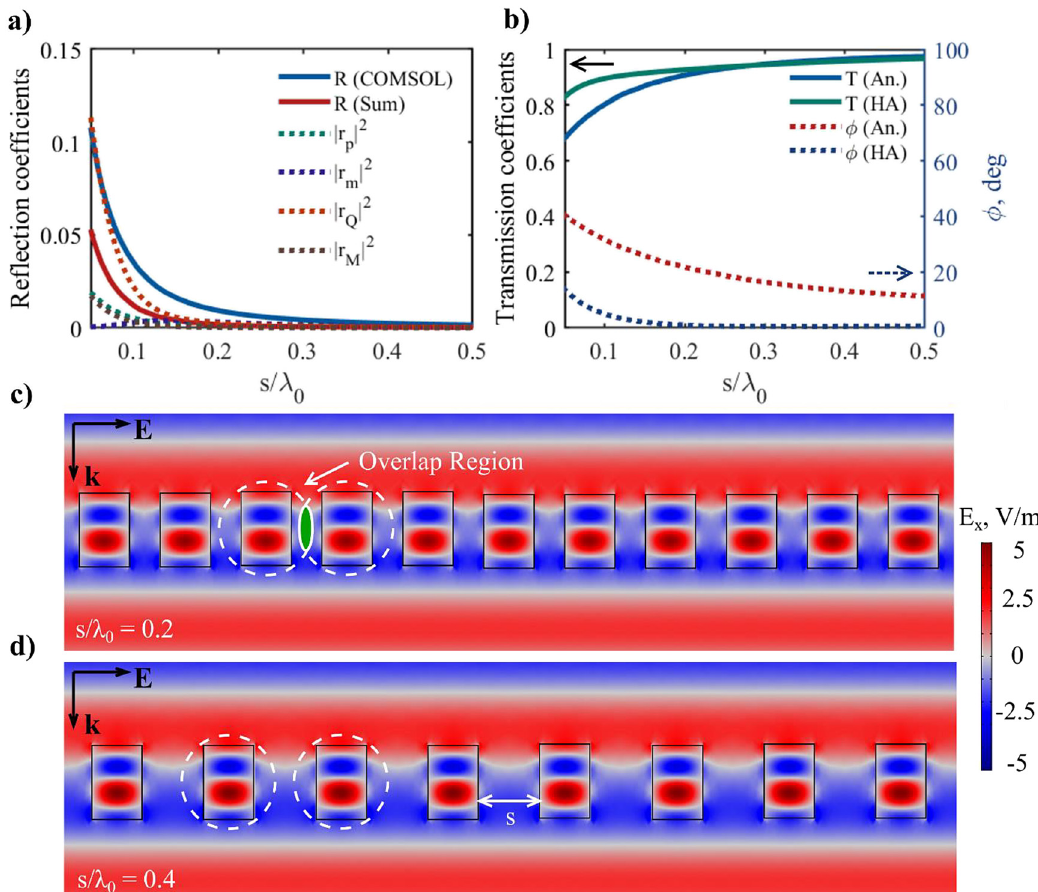
Figure2: OpticalresponseoftheHAmetasurfacewithparticleseparation s (thegeometricalparametersarethesameasinFigure1).Evolution of re fl ection (a), and transmission (b) at λ 0 . (c) and (d) x -component of the total electric fi eld for s / λ 0 = 0.2 – 0.4. The dashed circles depict a section of the smallest spherical surface enclosing the scatterer. For s / λ 0 = 0.2 they overlap, demonstrating that our metasurface retains the samephaseandtransmissioneven intheextremecasewhenthe ‘ equivalent ’ sphereswouldintersect.Inboth scenarios, the fi eldswithinthe meta-atoms remain virtually identical, and the incident fi eld is completely